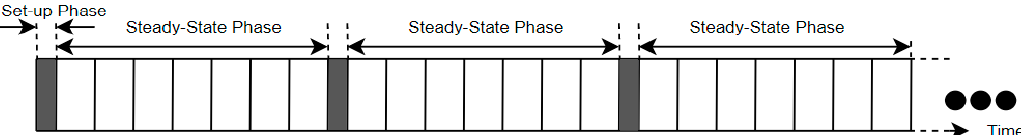
Figure 4. Timeline showing the overall operation of the algorithm.